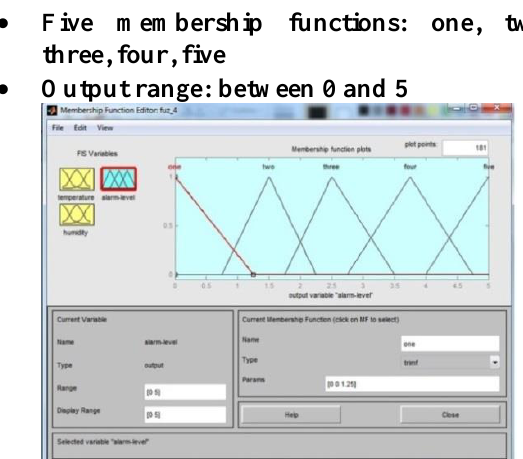
Figure 25. Membership functions for Alarm level (output) and its range